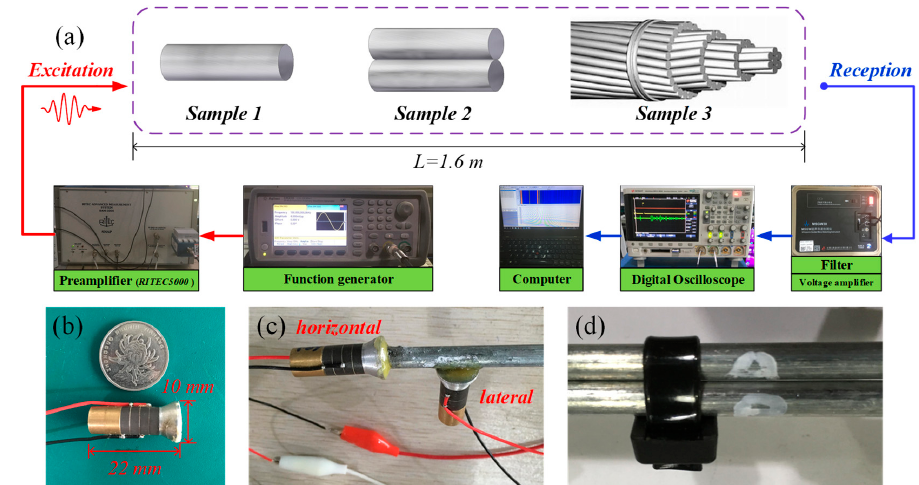
Figure 11. The experimental setup for guided wave excitation and reception in three types of samples. ( a ) The schematic of the experiment. Photos of ( b ) the piezoelectric (PZT) transducer, ( c ) the single wire experiment case, and ( d ) the two contact wires.